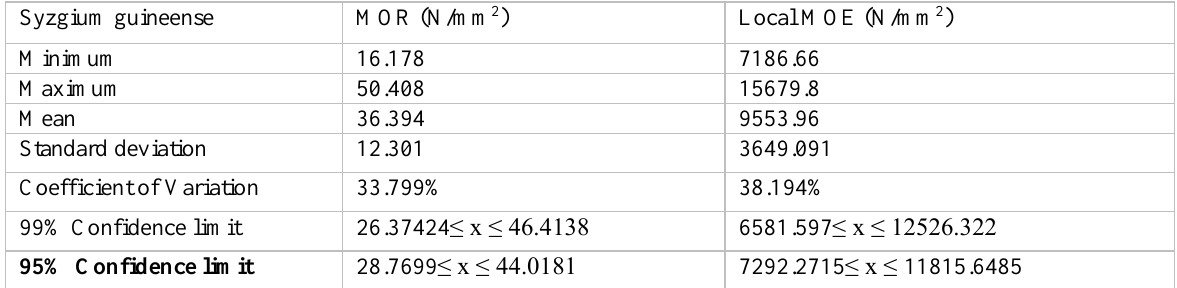
Bending Strength of Syzgium guineense